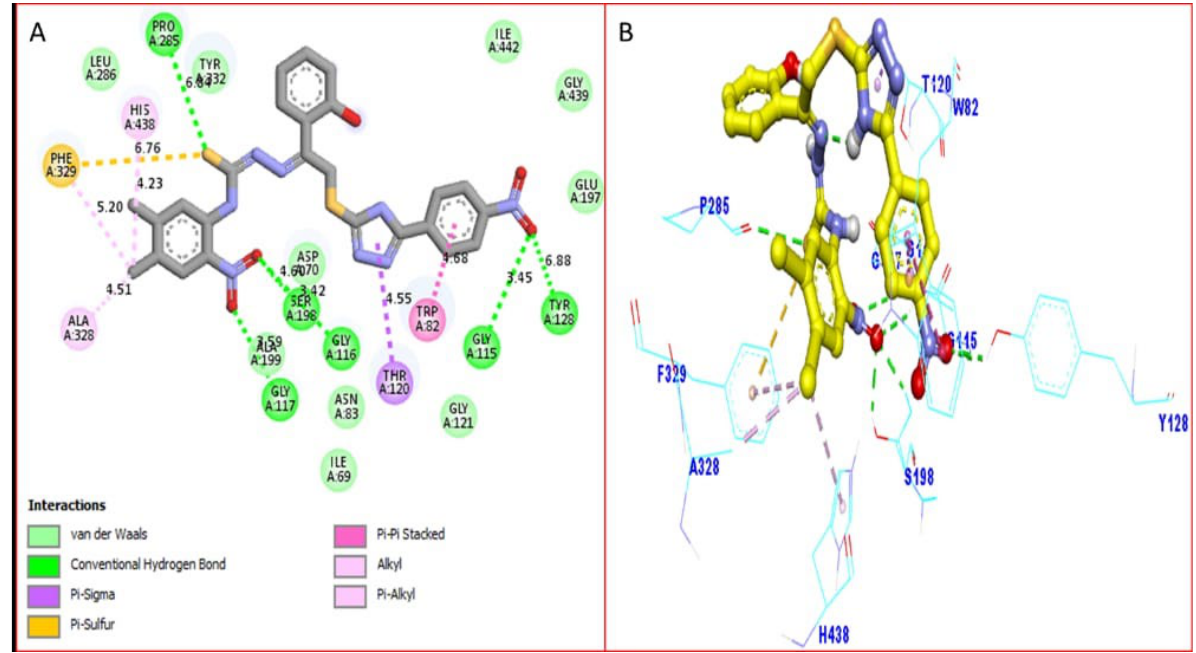
Figure 8. Protein–ligand interactions (PLI) profile of analogue 6b against butyrylcholinesterase (BuChE): ( A ) 2D; ( B ) 3D.